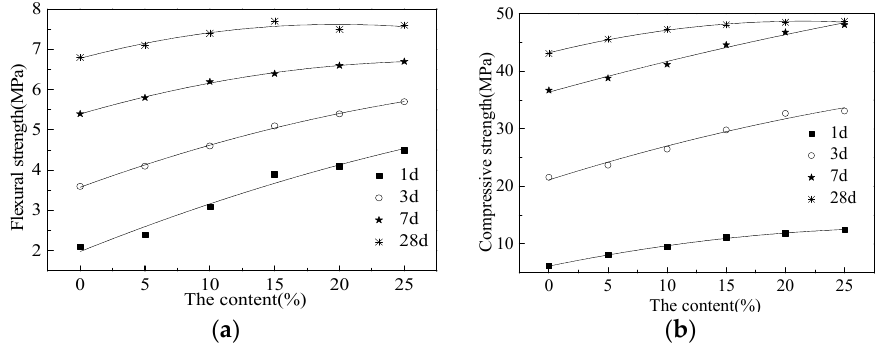
Table 4. The fitting results of electrical resistance and the curing time.